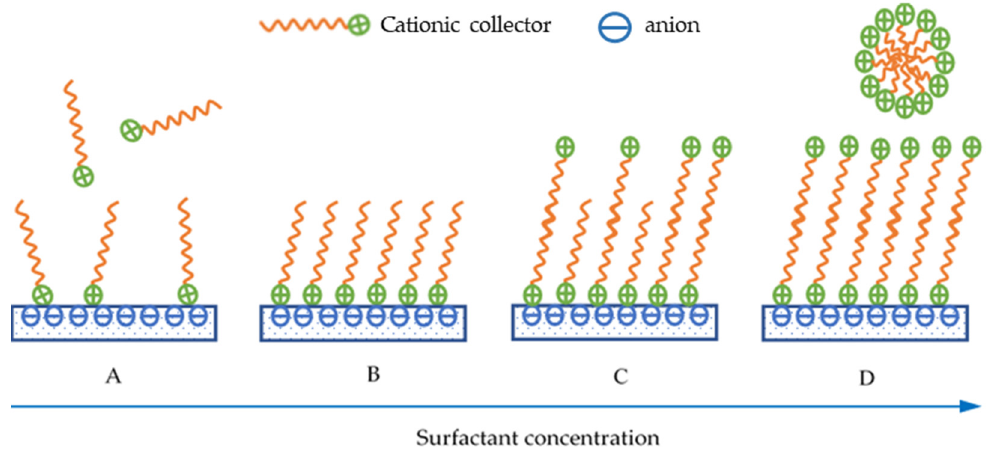
Figure 5. Speculated schematic model of a cationic collector / surfactant adsorption at the quartz / water interface over concentration. ( A : concentration < CHC; B : concentration = CHC; C : CHC < concentration < CMC; D : concentration = CMC)